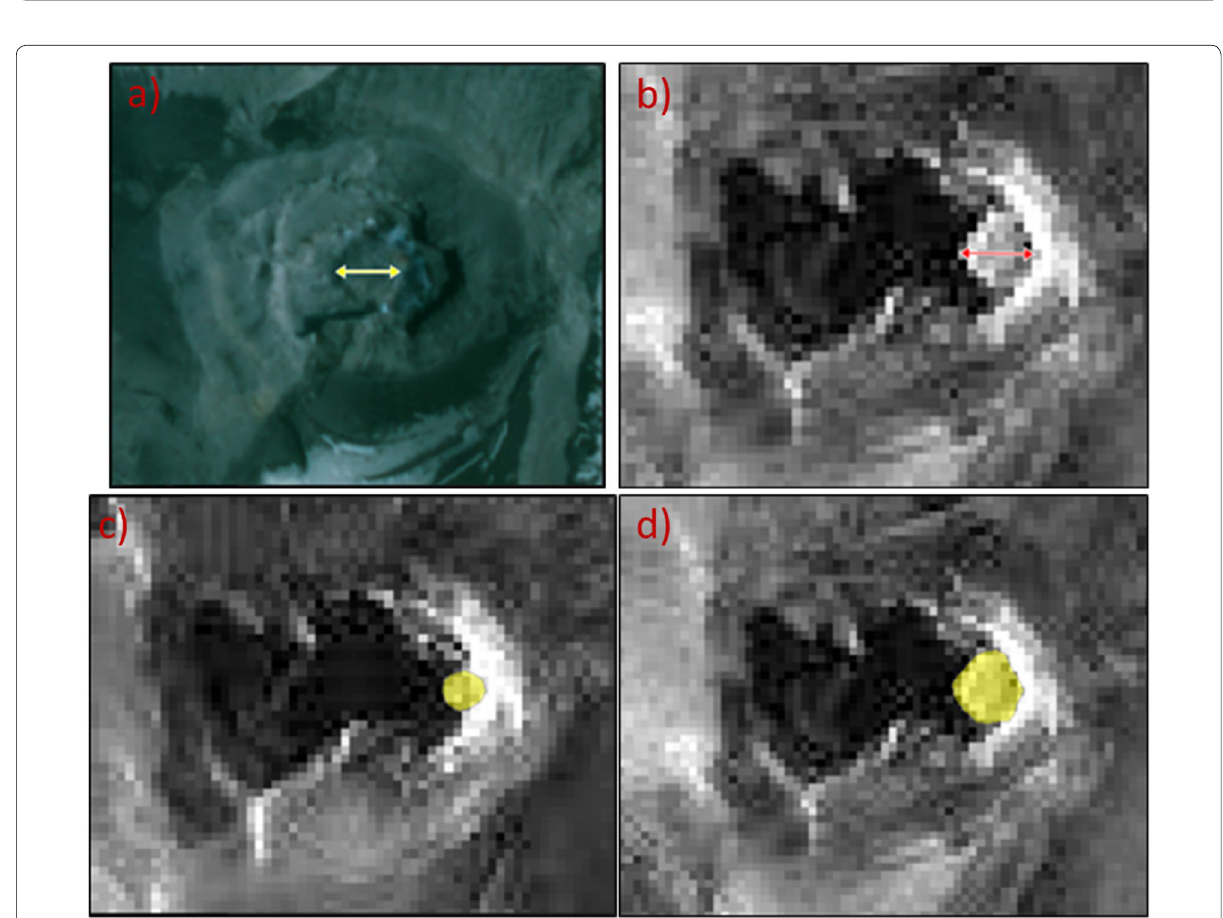
Fig. 10 Example of proposed method to calculate the area and volume over time of the lava dome: a reference for dome dimensions established from Planet Scope image (March 14, 2018). b Scaling from TerraSAR‑X image (April 9, 2018). c Example of digitized polygon defining the dome perimeter and area during November 11, 2015. d Example of digitized polygon defining the dome perimeter and area during May 25,